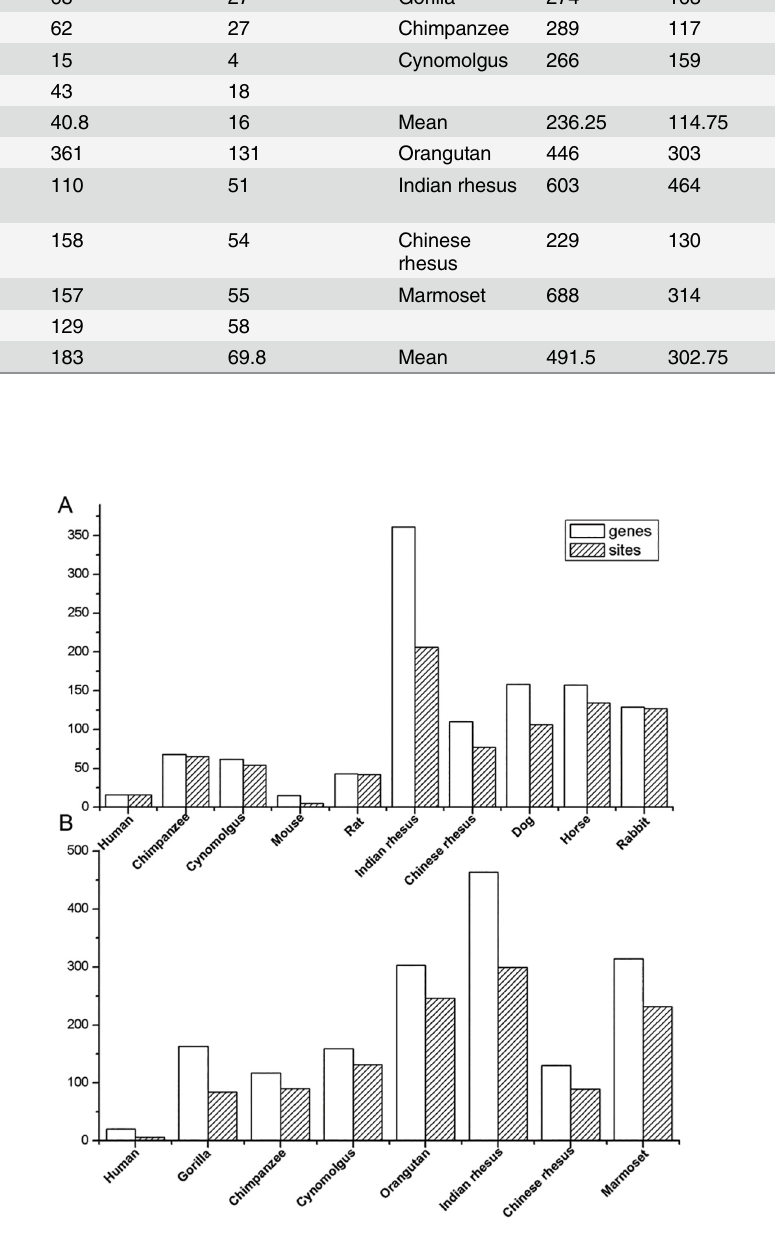
Fig 1. Numbers of positively-selectived genes (fdr < 0.05) and sites (after SP-score filtering). (A). Positively-selected genes corrected by FDR. Sites (BEB > 0.95) were filtered by SP scores in the Distant- Species set. (B). Positively-selected genes (FDR > 0.05) and positive sites (BEB > 0.95) filtered by general SP score > -50 and individual SP score > -15 in the Close-Species set.